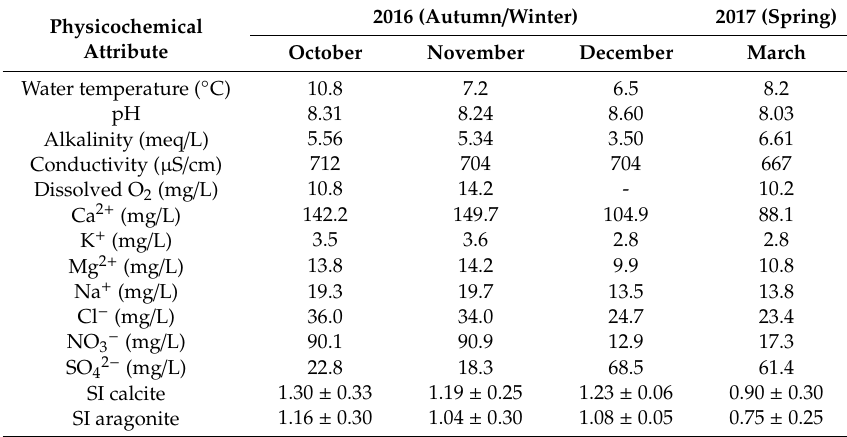
Table 1. Physicochemical characteristics at the biological sampling site during the four field excursions. SI = saturation